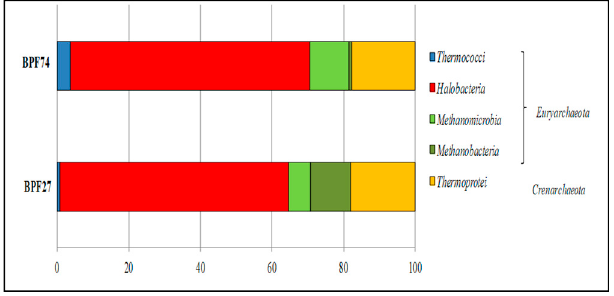
Figure 4. Archaeal community composition in fluids collected from Black Point site at high (BPF74) and low temperature (BPF27).